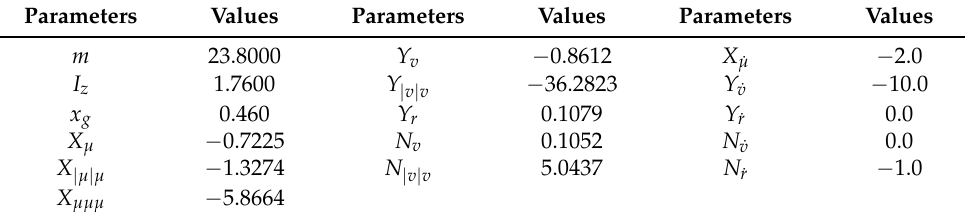
Table 3. Main parameters of CyberShip II.